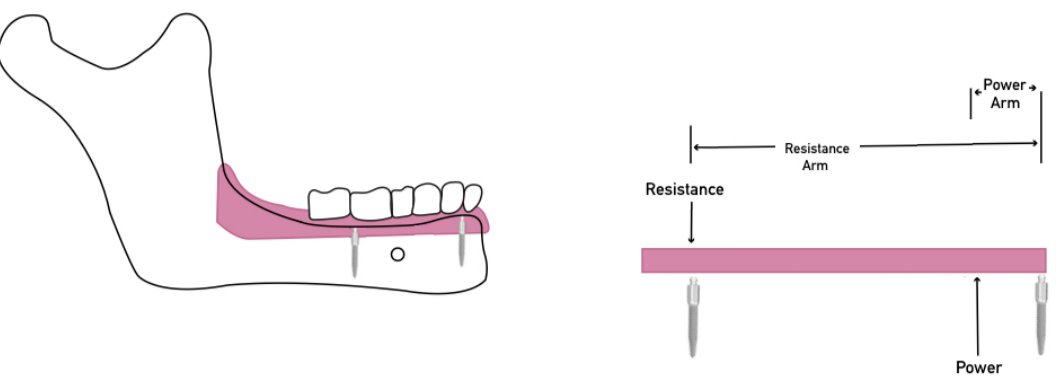
Figure 6. Class III lever system with anterior MDI act as a fulcrum, posterior MDI act as a resistance and the power is the anterior dislodging force. Placement of posterior MDI create a resistance point toward the anterior dislodgment force; notice the long resistance arm resulting from placing MDI posterior to the dislodgment force.